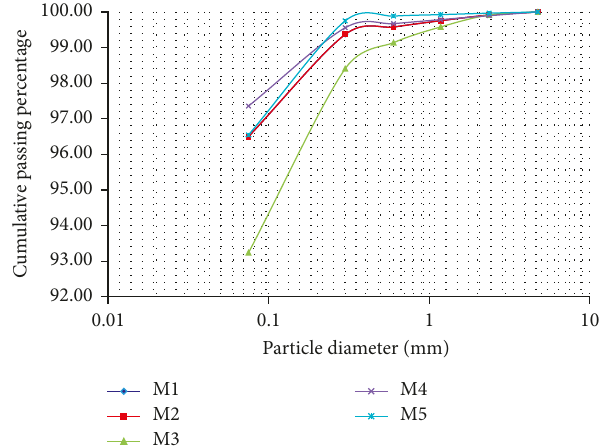
Figure 2: Quarry sieve analysis (own